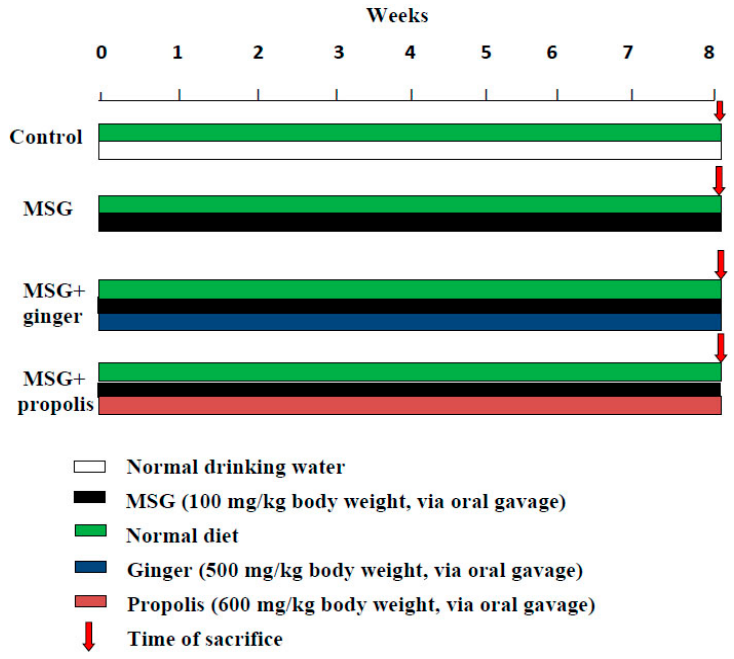
Figure 18. Schematic representation of experimental regimen.